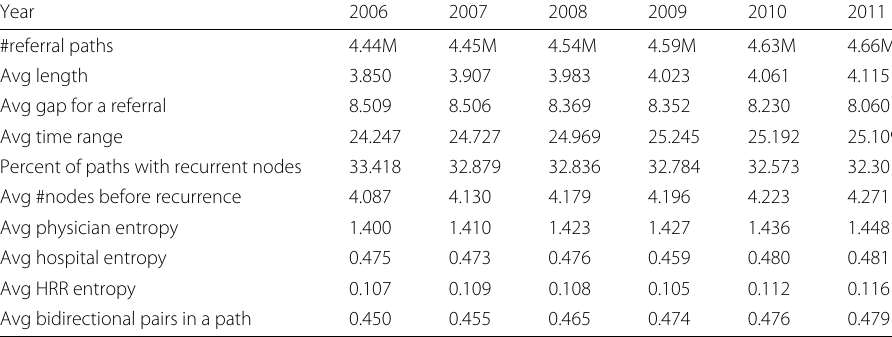
Table 3 Overall statistics of all referral paths in 2006-2011